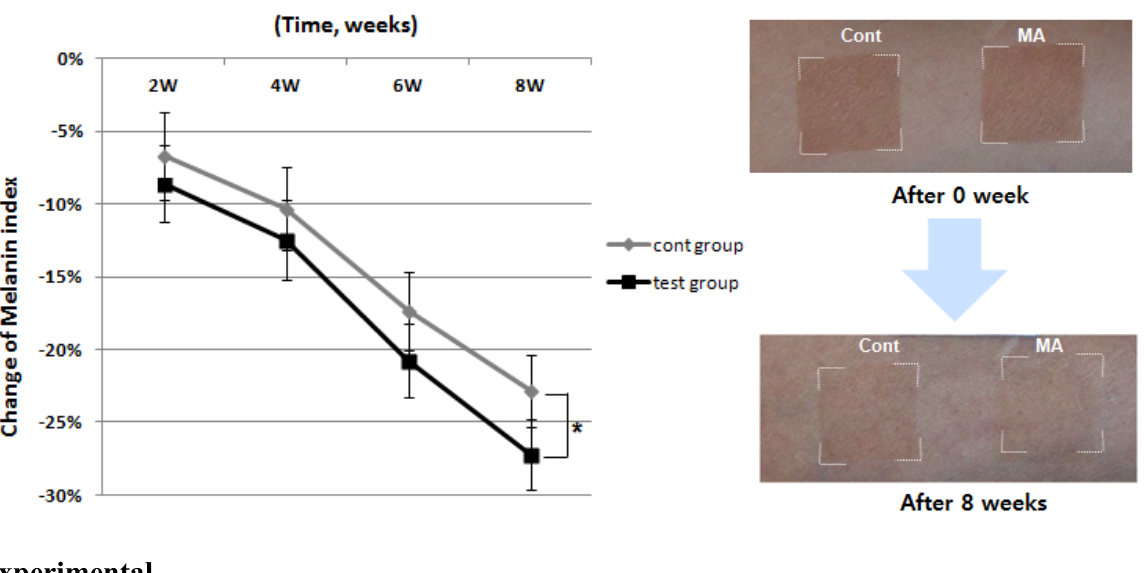
Figure 6. Effect of the MA on artificially tanned human skin in vivo . Analysis of melanin index by narrow band-spectral reflectance of light. Compared to the A group (control, cont), the melanin index was significantly decreased in the B group (MA, test) at 8 weeks ( p <